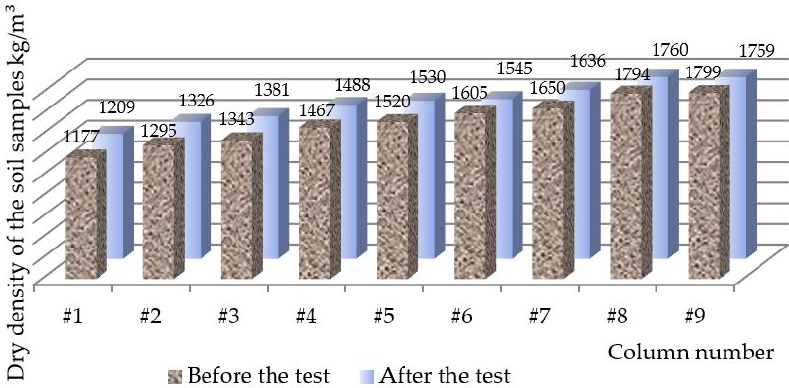
Figure 9. Dry density change of soil samples during two freeze–thaw cycles.